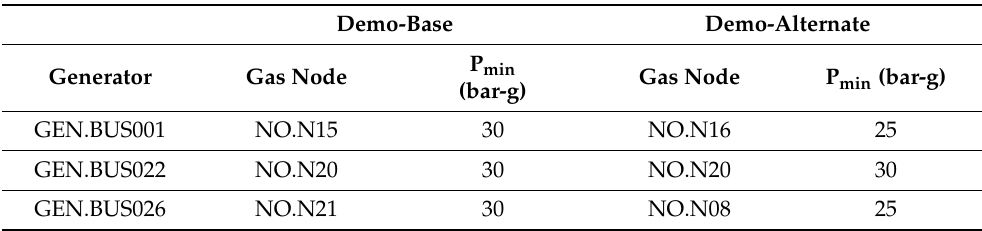
Table 2. Overview of coupled generators and gas node in each demo network, with details on the minimum delivery pressure (P min ) at each gas generator node. Demo-Base Demo-Alternate